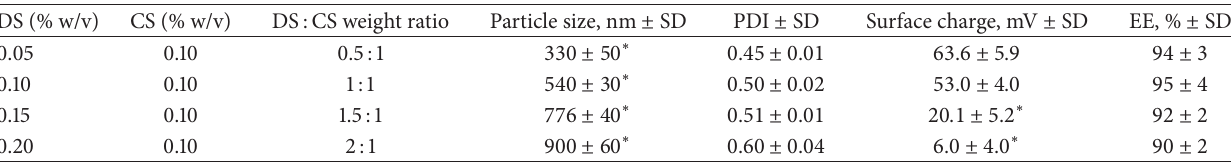
Table 2: Effects of DS: CS weight ratios on the physical characteristics of siRNA loaded CS NPs, 𝑛 = 3 . CS solution used for BSA loaded